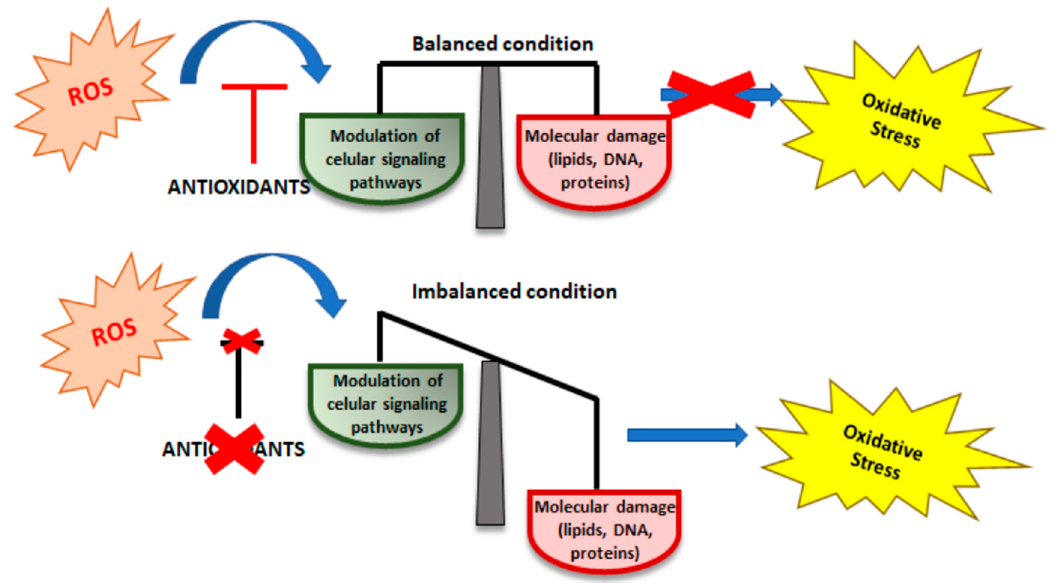
Figure 1. Balance between ROS production and antioxidant defense.